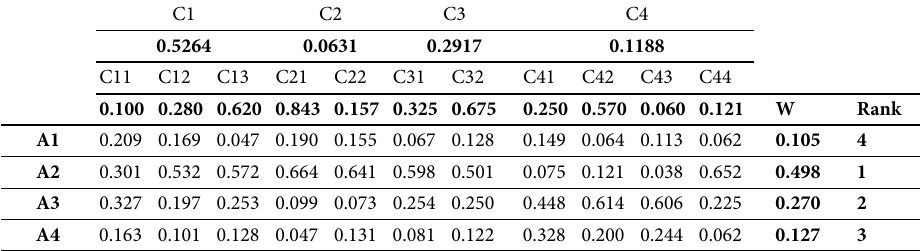
Table 10. The evaluation results for health investment alternatives C1 C2